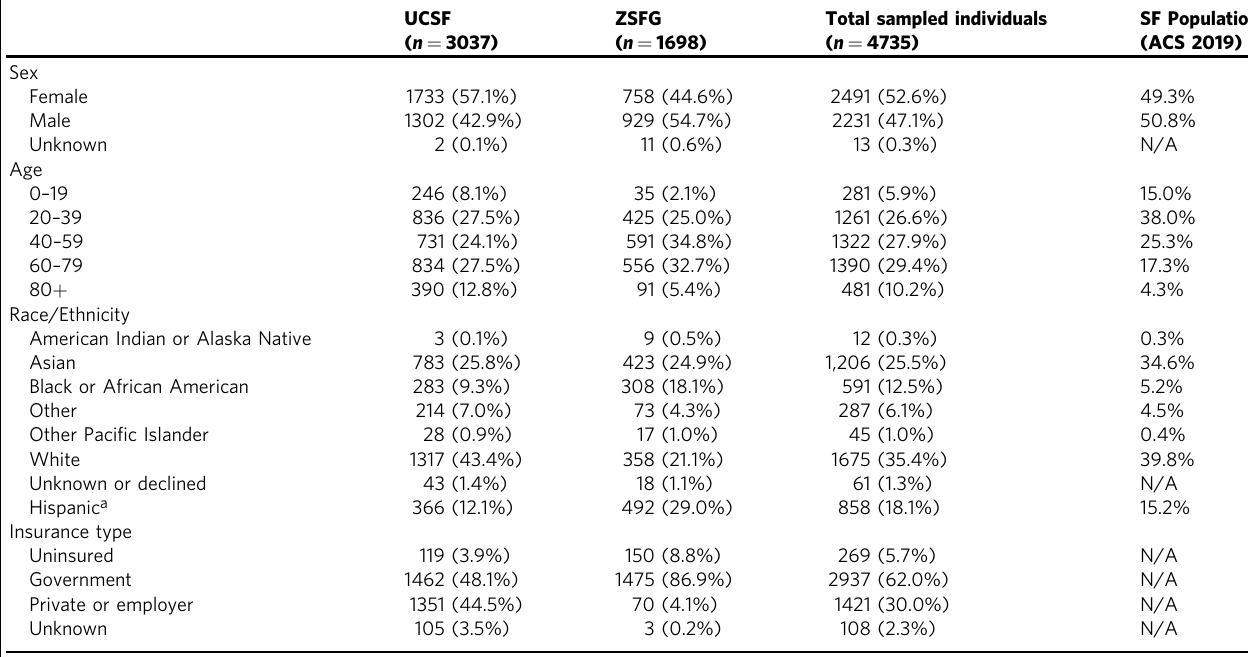
Table 1 Distribution of Socio-demographic characteristics of patients sampled. Table showing socio-demographic characteristics of patients sampled in SCALE IT and of the San Francisco population